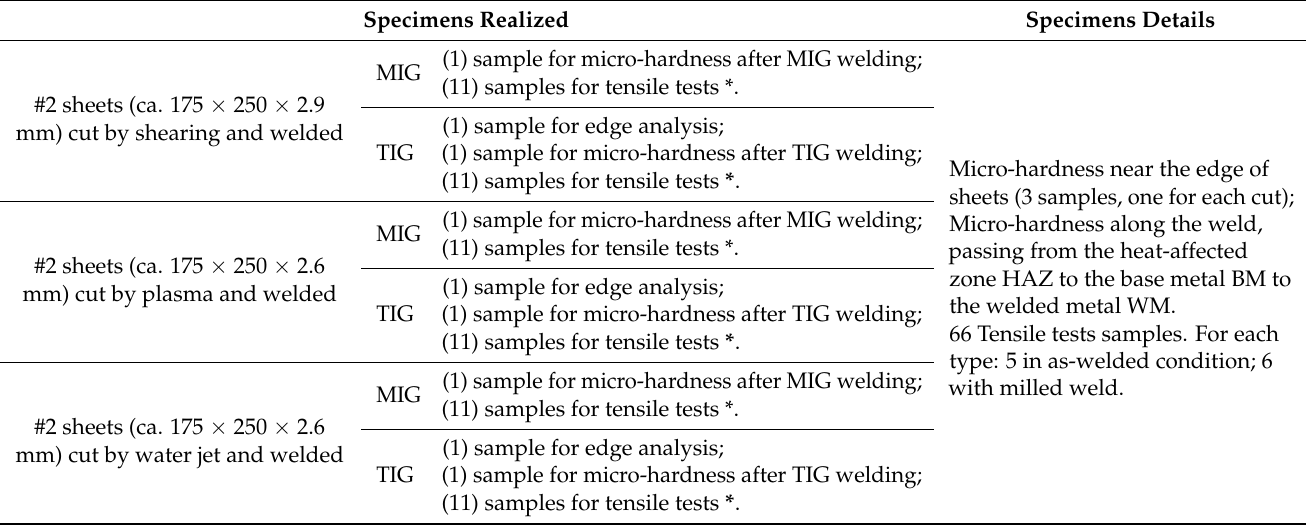
Table 3. Specification for specimen studied/tested.